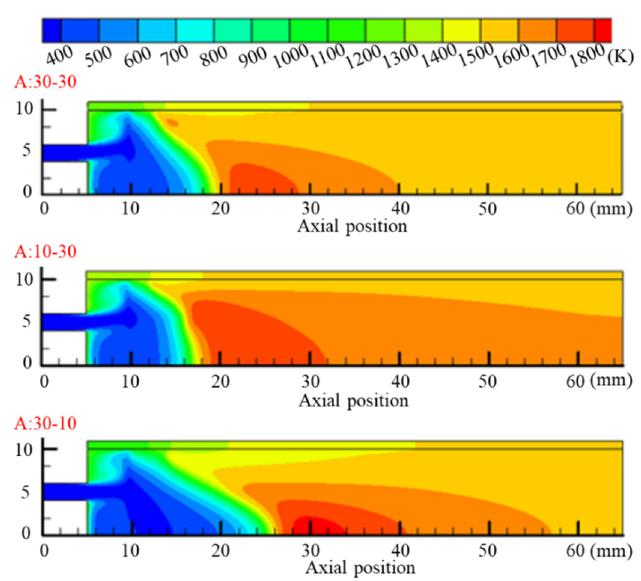
Figure 5. Temperature cloud diagrams with different layouts.